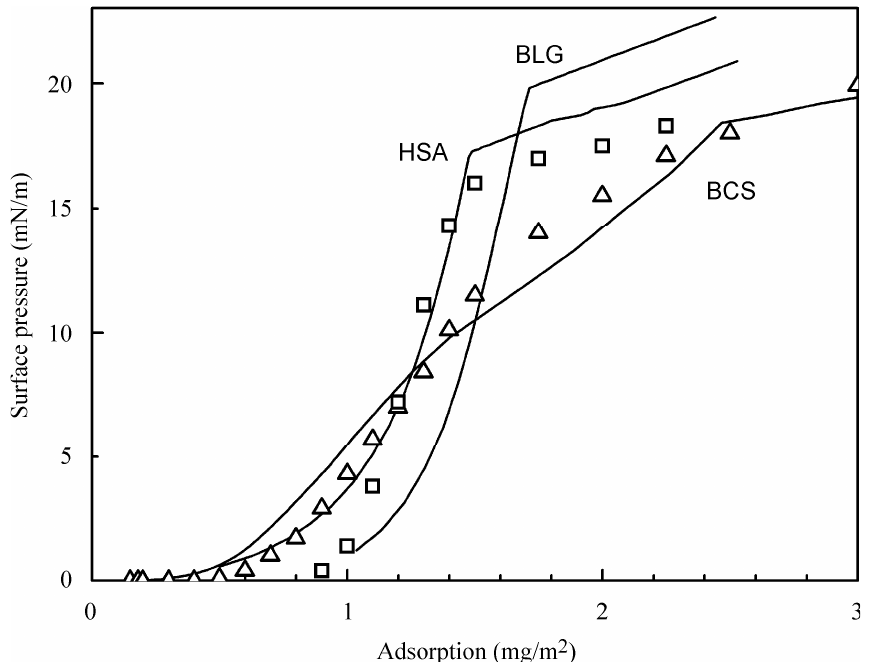
Figure 6. Dependencies of the surface pressure on adsorption for the three studied proteins. The experimental dependencies for HSA ( (cid:3) ) and BCS ( (cid:52) ) are obtained in [36,37].